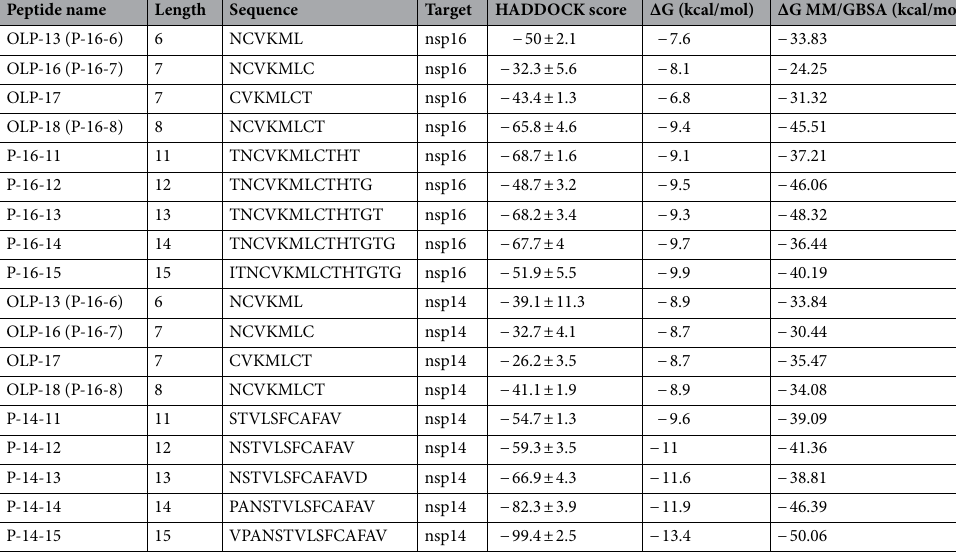
Table 2. List of the designed inhibitory peptides targeting nsp16 and nsp14 with their sequences, lengths, HADDOCK scores, binding free energies (ΔG), and MM-GBSA free